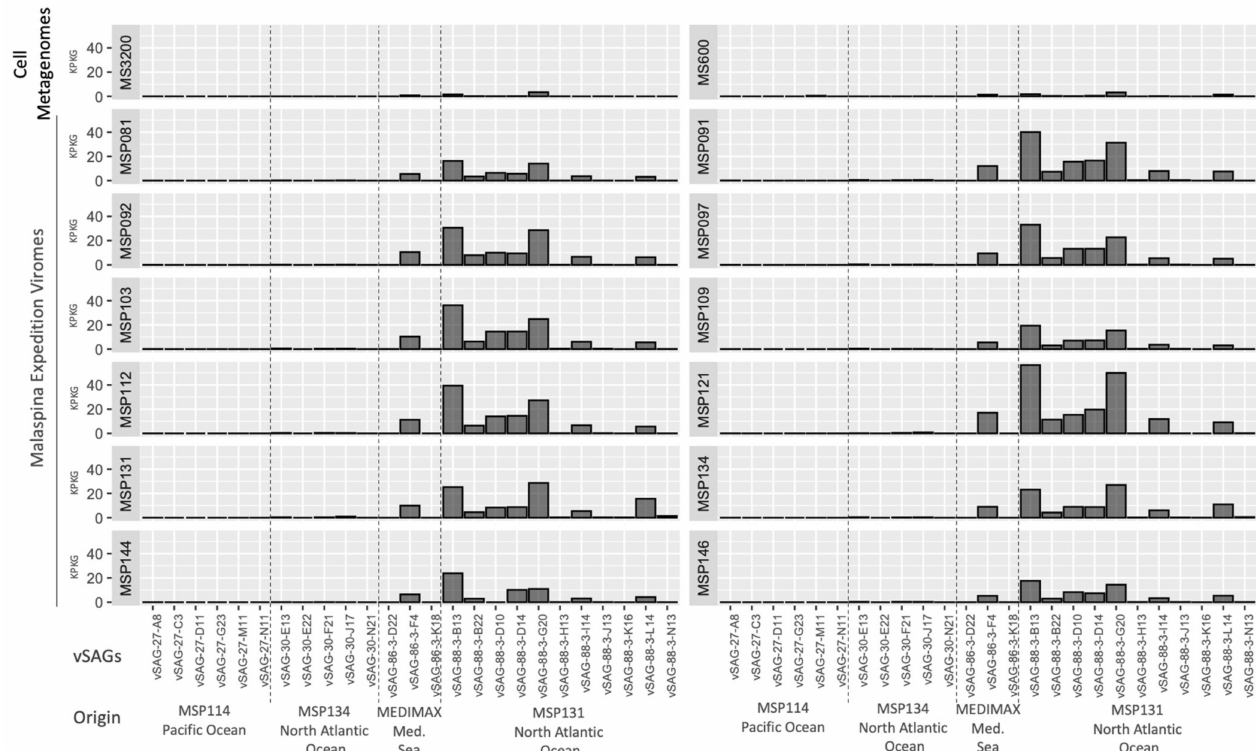
Figure 4. Abundance of vSAGs along different oceans. Abundance (as recruited kilobases per kilobases of vSAG genome length and gigabase of metagenome/virome, KPKGs) is calculated using two metagenomes (MS: Mediterranean Sea), and 12 bathypelagic viromes from the Malaspina expedition